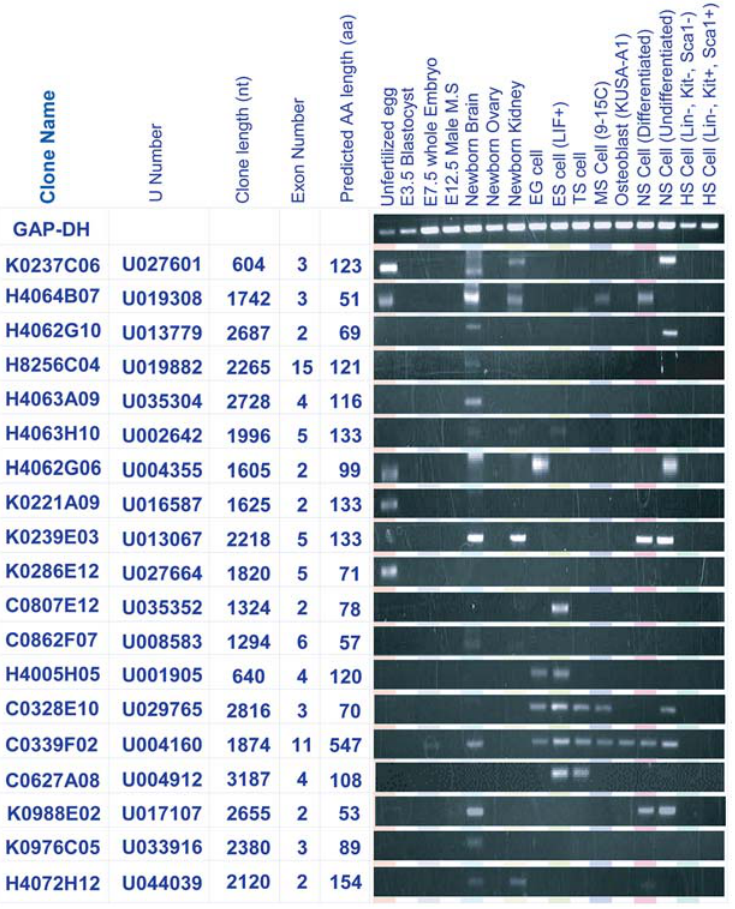
(Figure 2; Dataset S5). For example, the expression of gene U035352 was unique to ES cells, expression of U004912 unique to ES and TS cells, and expression of U001905 unique to ES and EG cells. In addition, one gene showed apparent specific expression in several stem cells and is thus a potential pan-stem cell marker ( U029765 ). Taken together, these data suggest that most of the putative genes represented only in the NIA cDNA collection are bona fide genes that have not been previously identified.